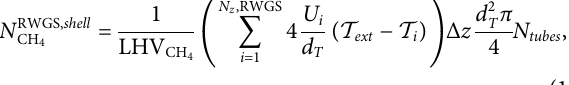
Frontiers in Energy Research |